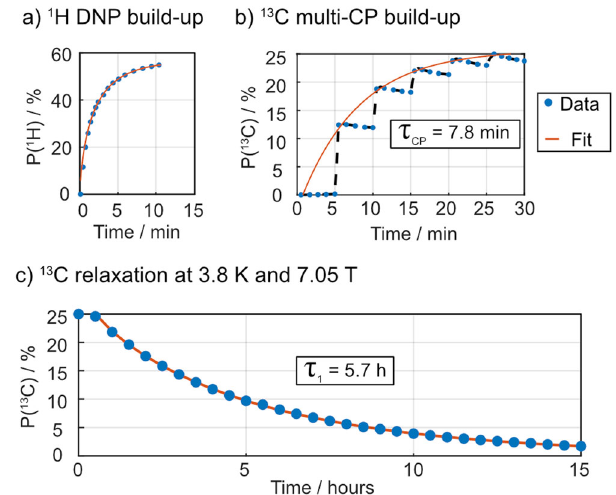
Fig. 4 13 C hyperpolarization and solid-state relaxation of target solution in HYPOP-I A . a 1 H DNP build-up of HYPOP-I A sample impregnated with a solution (see in the text) measured at 1.4 K and 7.05 T, with a microwave frequency of f uw = 197.648GHz with a triangular frequency modulation of width Δ f uw = 160 MHz and rate f mod = 500 Hz. b Subsequent multi-CP transfer of polarization to 13 C of target molecules. c Subsequent 13 C relaxation after warming the sample to 3.8 K, showing a characteristic decay constant T 1 ( 13 C) = 5.7 ± 0.1